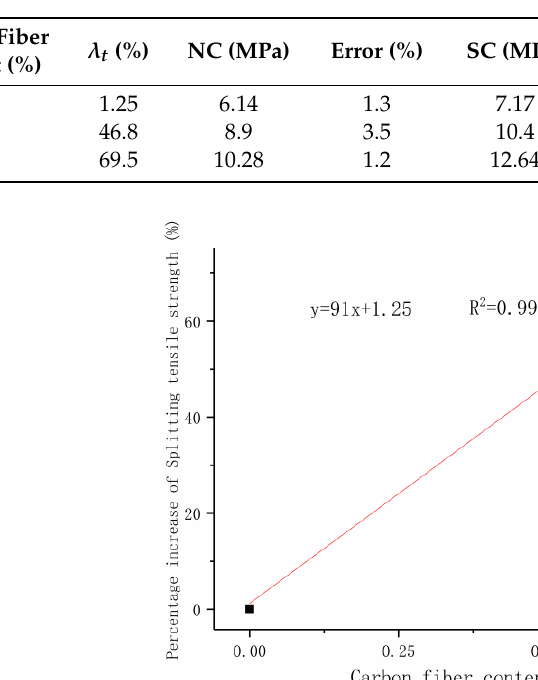
Table 11. Calculated splitting tensile strength of carbon-fiber RPC at 28 days.